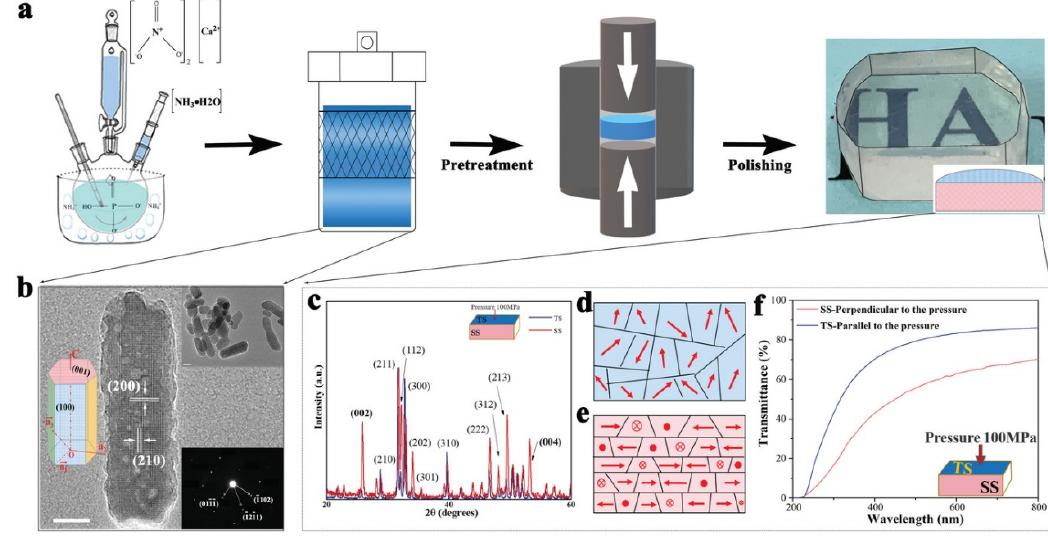
Figure 11. ( a ) Scheme for the preparation of hydroxyapatite (HA) optical material. ( b ) HRTEM image of the HA nanorods showing clear crystal lattice (scale bar, 10 nm). The images of mesoporous nanorods (scale bar, 20 nm) and the related selected area electron diffraction. ( c ) X-ray diffraction (XRD) patterns of the section and surface of HA ceramics prepared at 850 °C, with the increased peak intensity at (002), (004) showing that the grains have a pronounced orientation perpendicular to the pressure direction. Abridged general view ( d , e ) of the spatial distribution of HA grains c-axis (red arrow lines) in different pressure surfaces, exhibiting a preferable arrangement with their c-axis in the planes overlay perpendicular to the pressure direction; ( f ) The linear transmittance of HA ceramic with incident light perpendicular to and parallel to pressure directions, respectively. Reproduced with permission [7]. Copyright 2020, Wiley-VCH.